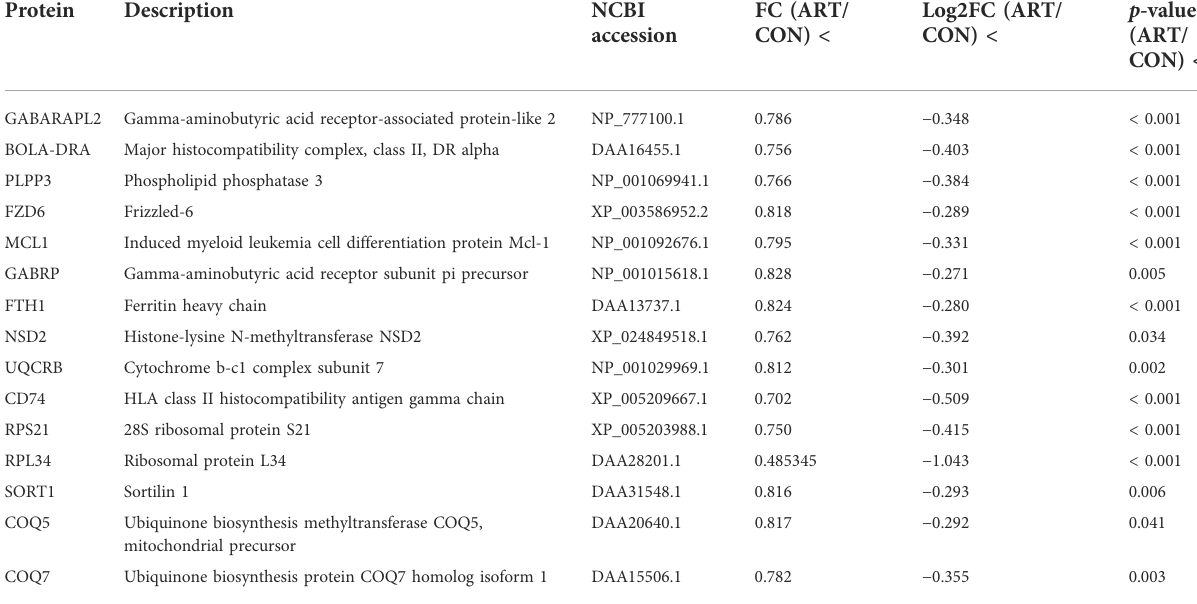
TABLE 3 Selected signi fi cantly downregulated proteins in the artemisinin (ART) group compared with the control (CON) group.